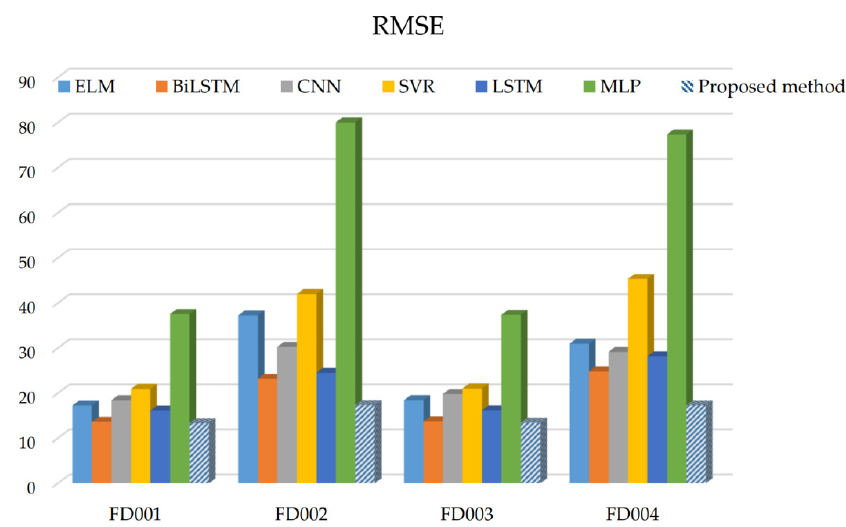
Figure 5. The results of RMSE comparison among different methods.